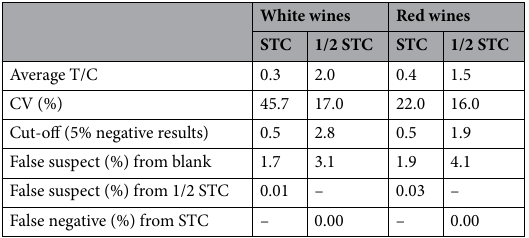
Table 5. Validation of the lateral flow immunoassay to determine SP residues as the sum of SP + SP-enol in wine samples (n = 20). The STC was set at 1000